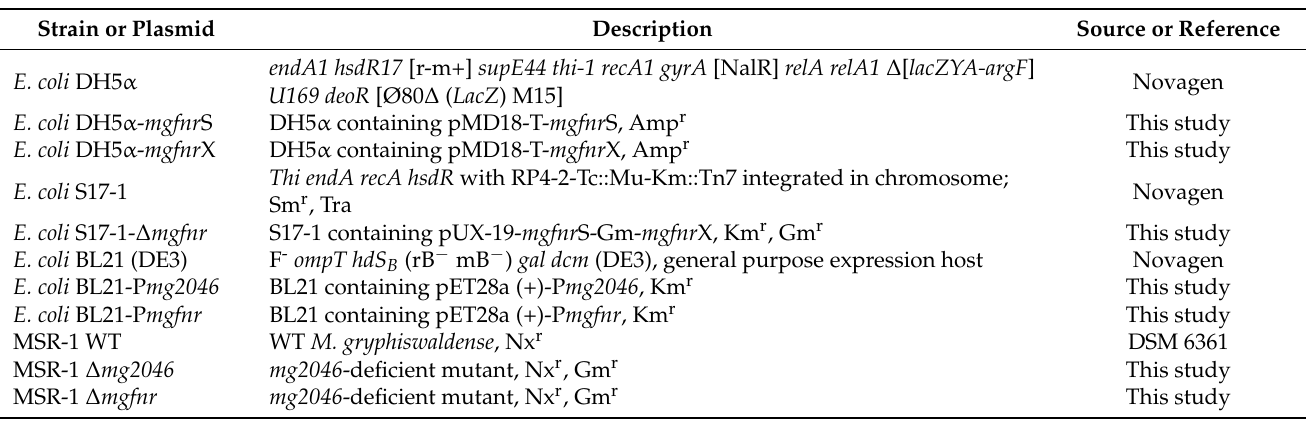
Table 2. Strains used in this